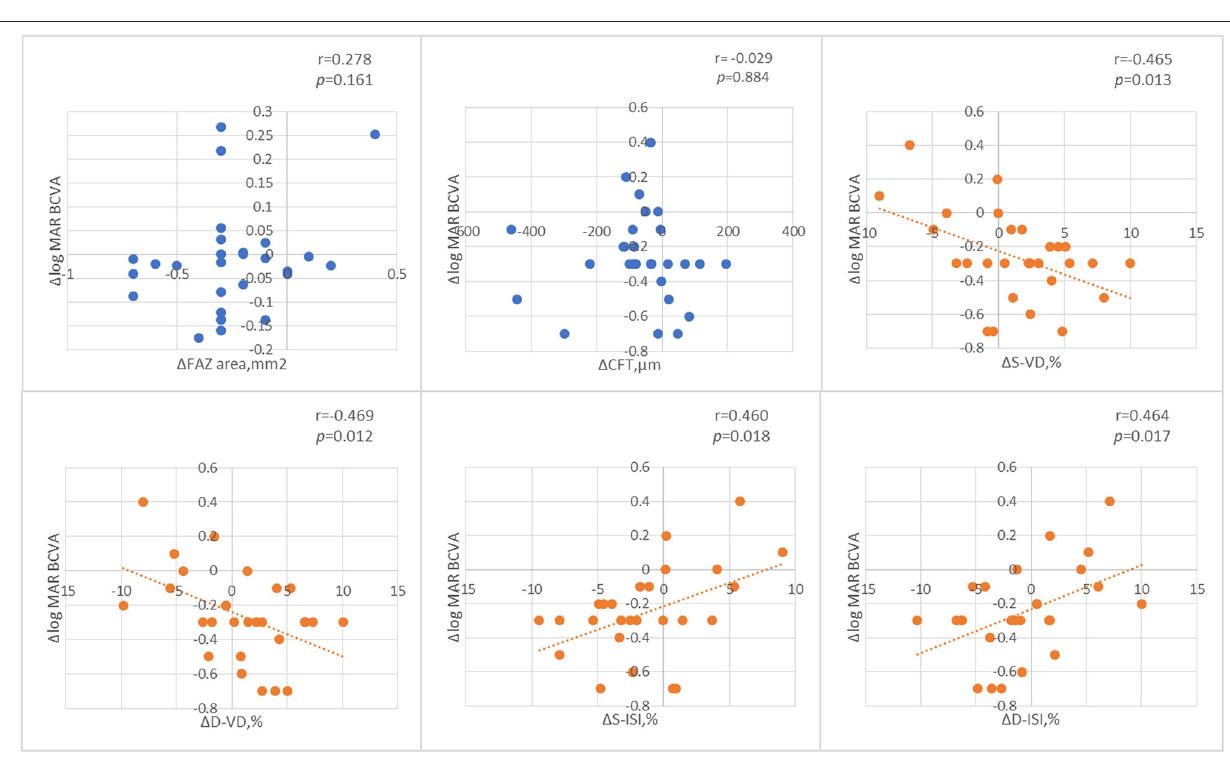
only a few (1.7%) patients presented a significant increase in nonperfusion areas (NPAs) greater than 1.0 in the disk area (3). However, a natural history of RVO showed that retinal ischemia would develop gradually and irreversibly